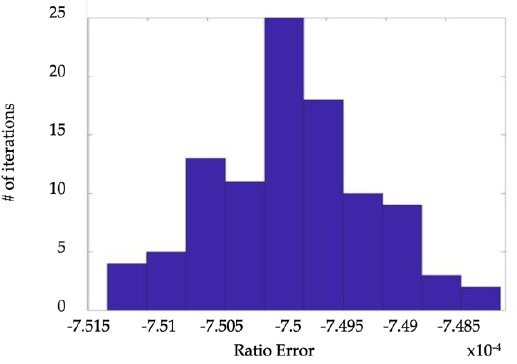
Figure 8. PDF of the measured Phase Error obtained in [11] for the case recalled in Table V.